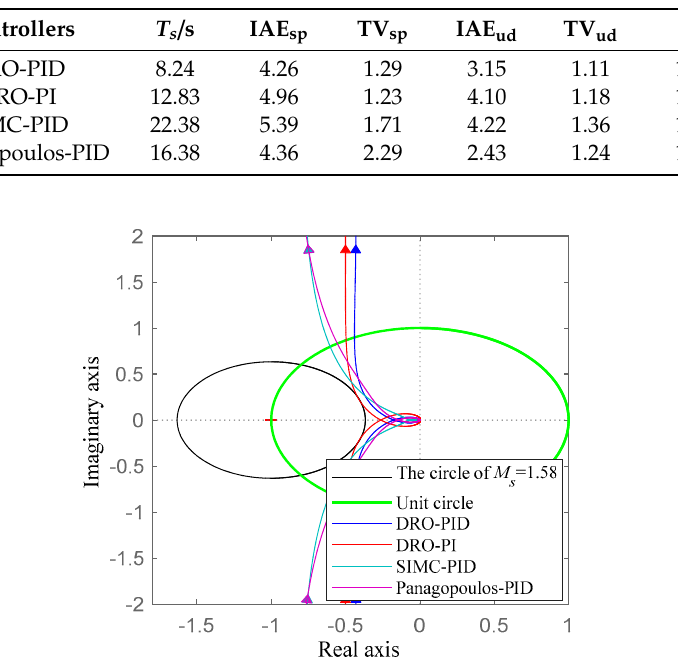
Figure 6. The Nyquist diagram for Example 1 with different controllers.